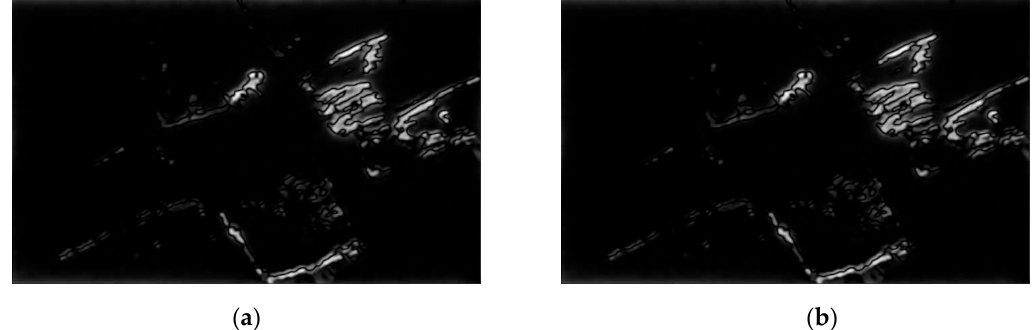
Figure 20. Comparison of two adaptive feature extraction algorithms: ( a ) output image based on PSO; ( b ) output image based on LPSO.